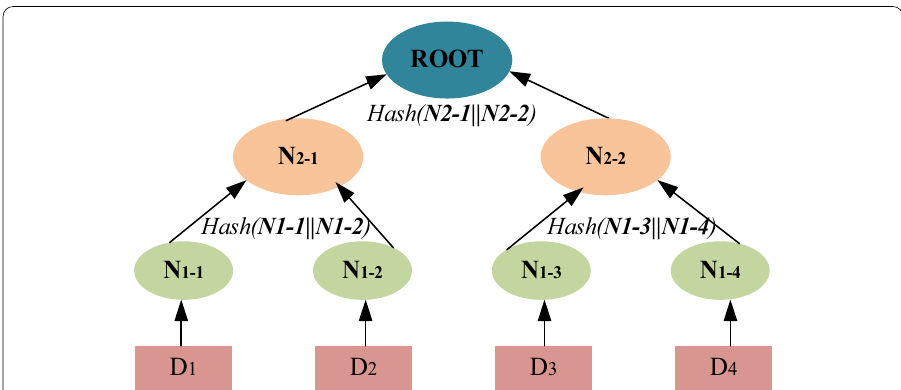
Fig. 2 Schematic diagram of the authentication path of the Merkle Hash